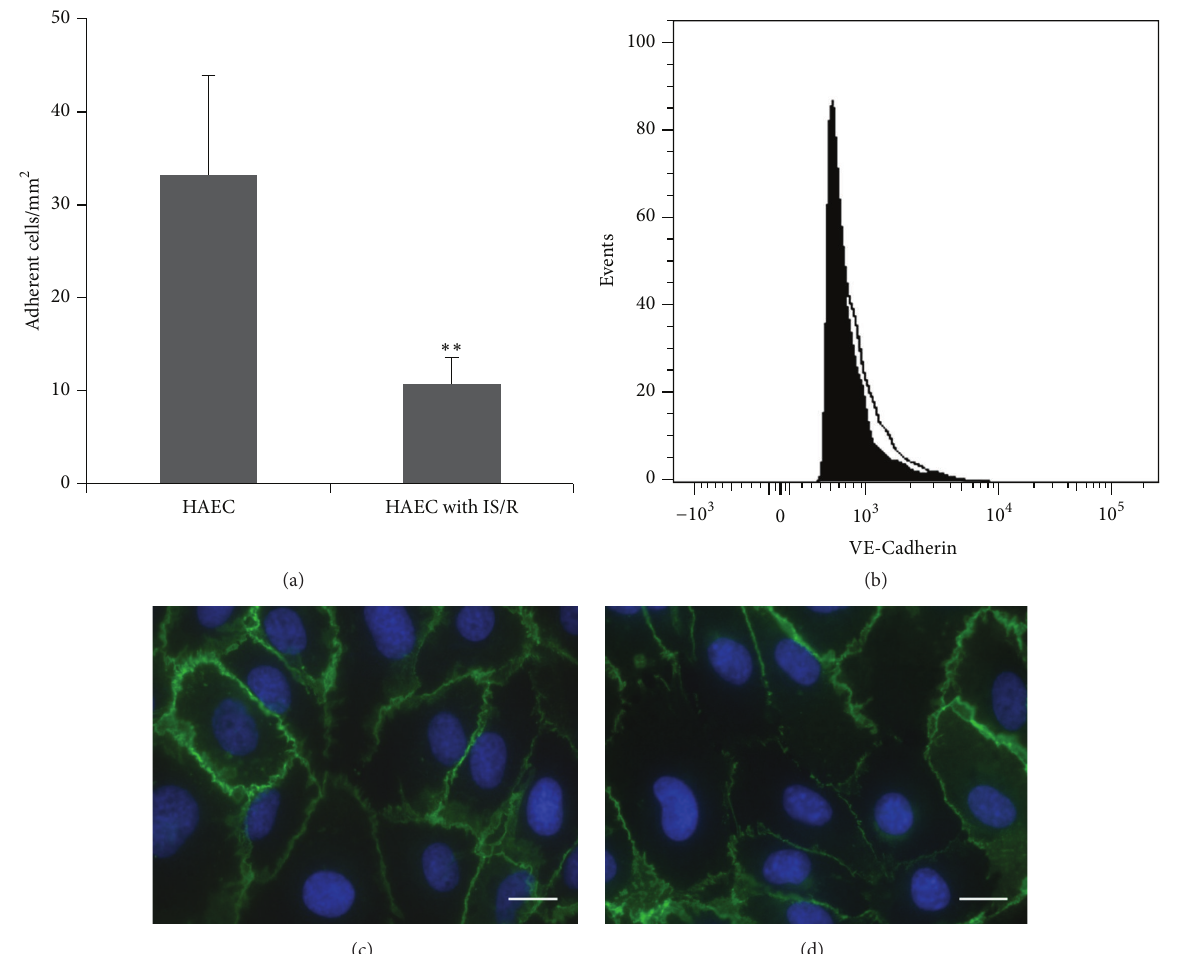
Figure 4: Dynamic interaction of LO-EPC with control HAEC and HAEC with ischaemia reperfusion injury (a). The data represented as mean ± SE of three experiments. ∗∗ 𝑝 < 0.01 . Representative flow cytometric histograms of VE-Cadherin expression in control HAEC and HAEC with ischaemia reperfusion injury (b). The filled histogram represents VE-Cadherin expression in control HAEC and the unfilled histogram represents VE-Cadherin in HAEC with ischaemia reperfusion injury. Representative microscopic images of VE-Cadherin expression in control HAEC (c) and HAEC with ischaemia reperfusion injury (d). Scale bar 20 𝜇 m.